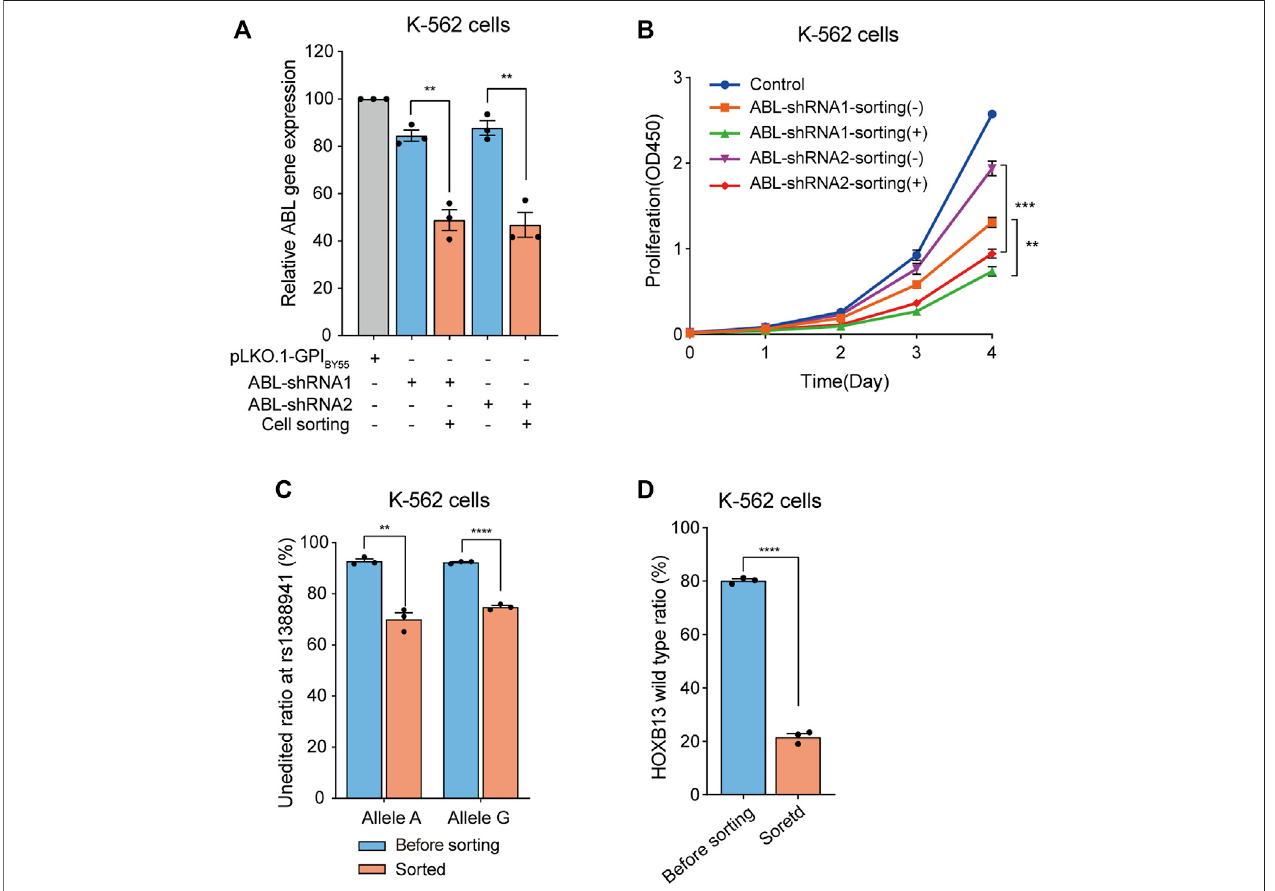
FIGURE 6 | Application of cell sorting in shRNA knockdown and CRISPR/eCas9 gene editing. (A) Bar chart showing the relative ABL gene expression level in K- 562 cells transfected with the pLKO.1-GPI BY55 vector expressing ABL-shRNA1 and ABL-shRNA2, enriched or not by cell sorting. Values are from three RT-qPCR experiments. (B) The cell proliferation analysis of the K-562 cells expressing ABL-shRNA1 or ABL-shRNA2, with or without enrichment by af fi nity cell sorting, measured using theCCK-8kit. Datafrom three biological replicate wells. (C) Bar chart showing genome editing frequency at rs1388941 locus inK-562 cells transfected with CRISPR/eCas9-GPI BY55 vector encoding sgRNA targeting rs1388941 region, with or without enrichment by cell sorting. The values represent the allele-speci fi c unaltered gene percentage from three getPCR experiments. (D) Genome editing in K-562 cells using CRISPR/eCas9-GPI BY55 vector encoding the HOXB13 gene sgRNA. The values represent the unaltered gene percentage from three getPCR experiments. Error bars, means ± SEM. ** p < 0.01, *** p < 0.001, and **** p < 0.0001as determined by an unpaired, two-tailed Student ’ s t-test.